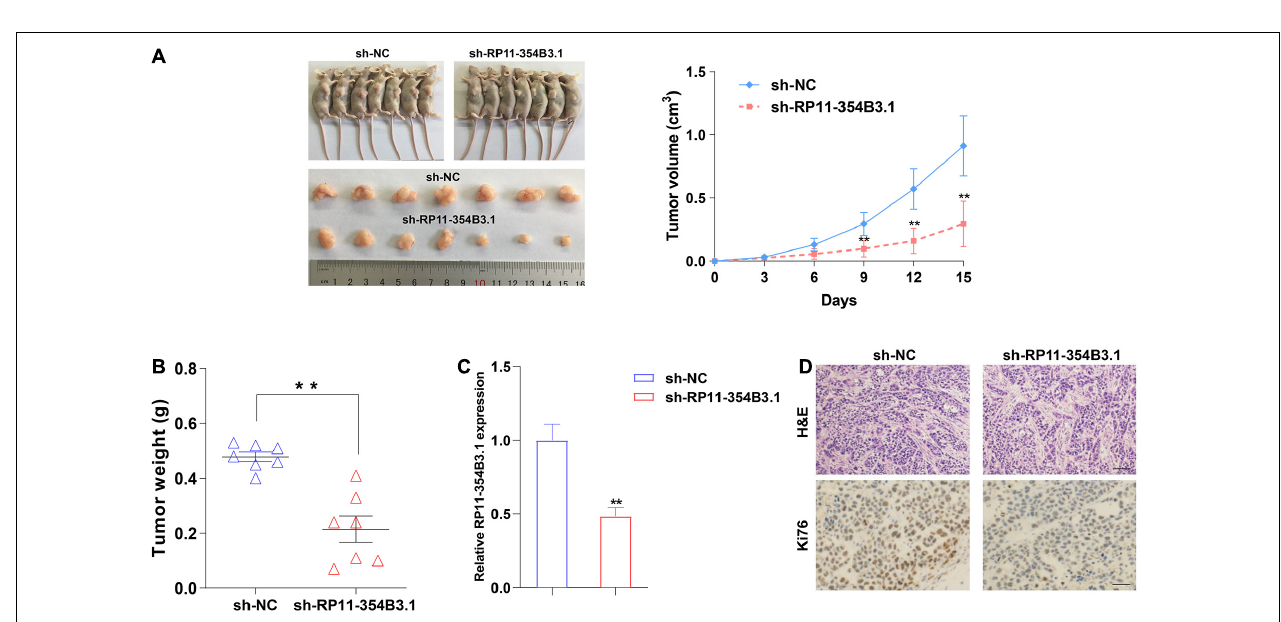
FIGURE 3 | The effects on tumor growth after RP11-354B3.1 downregulation in vivo . (A) Representative images of mice bearing tumors derived from cells expressing empty vector or sh-RP11-354B3.1, and tumor volume vs. time growth curves. (B) Tumor weight when the tumors were harvested. The tumors were collected from 7 mice in each group. (C) qPCR analysis of RP11-354B3.1 expression level in tumor tissues formed from sh-RP11-354B3.1 or sh-NC stably transfected cells ( n = 7 in each group). (D) Representative images of HE staining and Ki-67 immunohistochemistry of the tumors. ** P < 0.01.